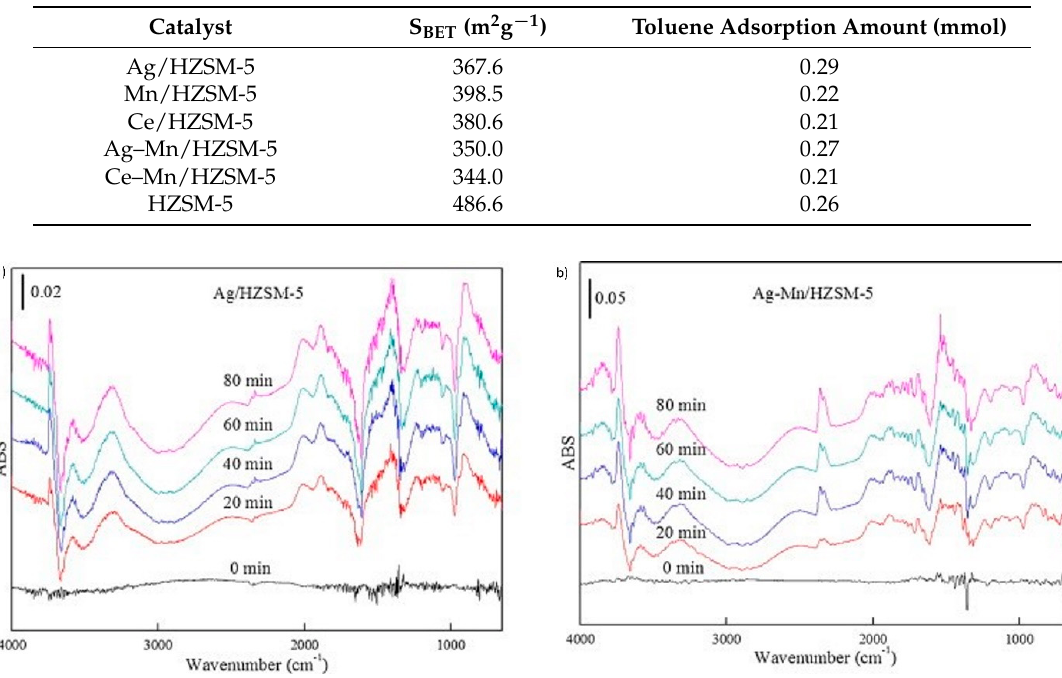
Figure 12. The diffuse reflectance infrared Fourier transform spectra (DRIFTS) of catalyst surface with adsorbed toluene ( a ) Ag/HZSM-5 and ( b ) Ag–Mn/HZSM-5 catalysts. Reprinted from Reference [38], with permission from Elsevier.